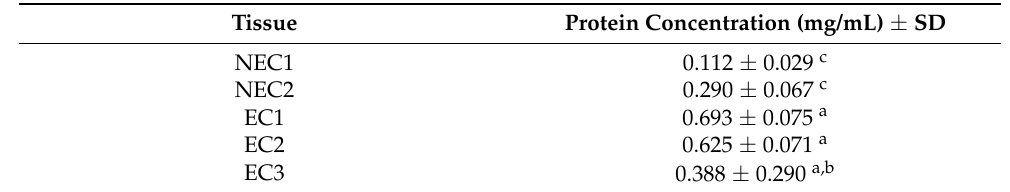
Table 2. Total protein content in the different calli . Results are presented as mean ± SD ( n = 3). Different letters are significantly different according to Tukey test ( p <